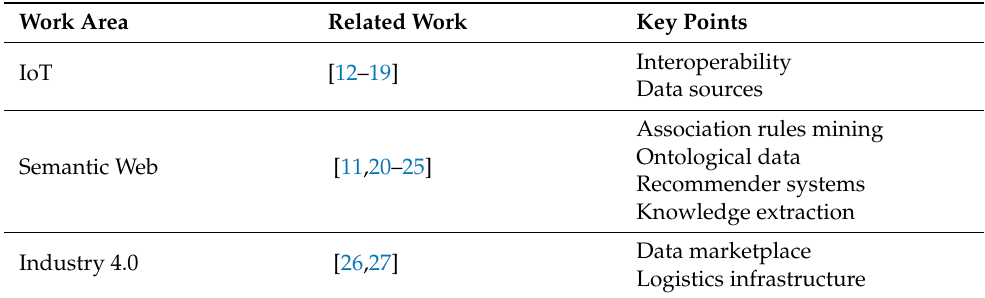
Table 1. Grouping of semantic data-mining